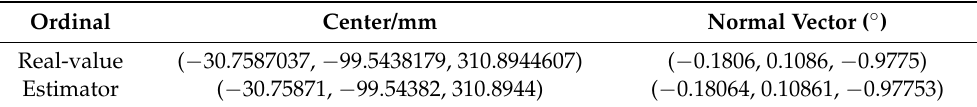
Table 2. Feasibility simulation results of parameter extraction method.